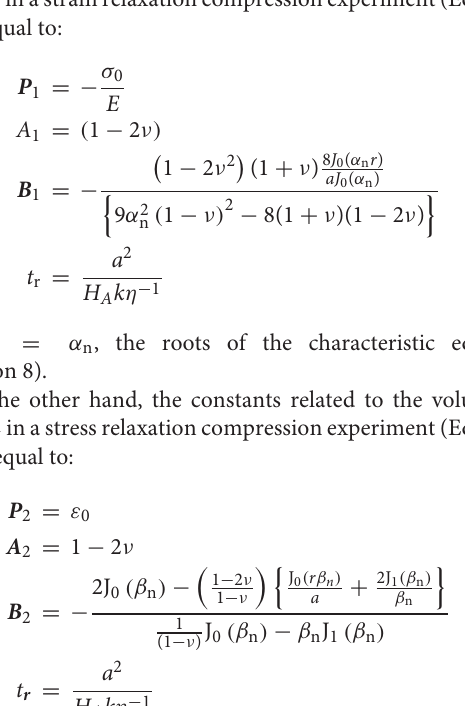
The constants of Equation (15) that are related to the volumetric strain ε v in a strain relaxation compression experiment